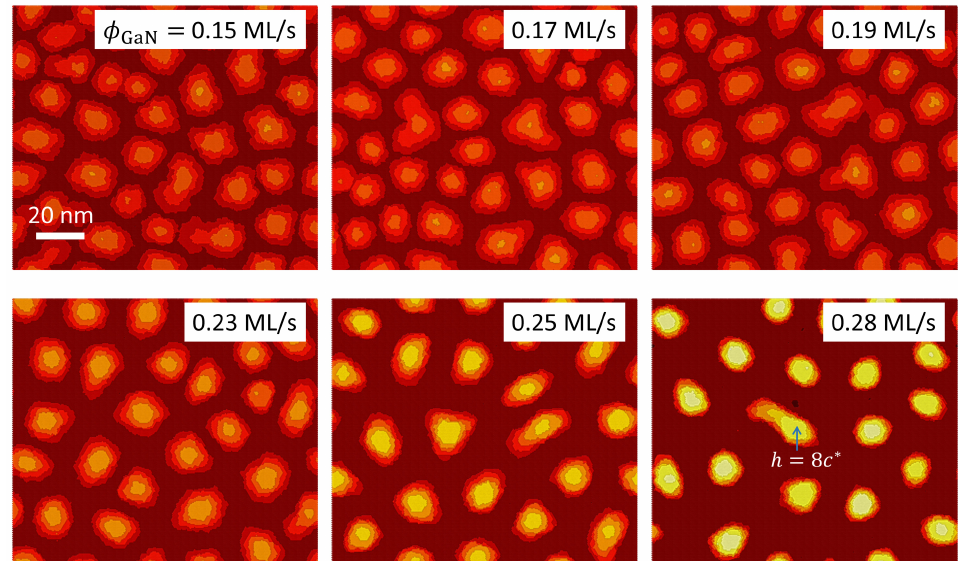
Figure 6. Surface morphology of a GaN epitaxial layer grown on an AlN substrate for simulations with different nominal Ga fluxes φ Ga (specified in each panel of the figure). The N flux φ N has been set at 0.28 ML/s. The color scale indicating the discrete height is the same for all panels. A reference height is provided in the panel for φ Ga = 0.28